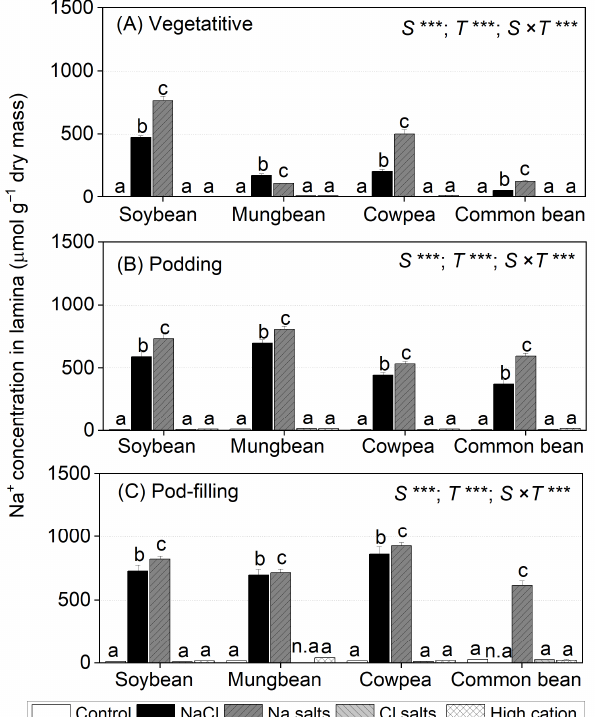
Figure 2. Na + concentration in lamina of soybean, mungbean, cowpea, and common bean grown in control (non-saline), 100 mM NaCl, 100 mM Na + (without Cl − ), 100 mM Cl − (without Na + ), and high-cation negative control (K + , Mg 2+ , and Ca 2+ equivalent to those in the 100 mM Cl − treatment) treatments. The salts used in the various treatments are given in Table 1. The treatments were imposed on 13-day-old plants and sampled after ( A ) 15 (vegetative stage), ( B ) 36 (podding stage), and (C57 (pod-filling stage) days of treatment. The values are means ± SE ( n = 4). Significant differ- ences for treatment means within each species are indicated by different letters (a–c) ( p = 0.05). The probability levels for two-way ANOVA were used to compare species (S), treatment (T), and spe- cies × treatment interaction (S × T) effects (*** p < 0.001). Note: Mungbean subjected to Cl – (without Na + ) and common bean subjected to the NaCl treatment did not have enough green leaf lamina at the pod-filling stage for ion analysis, as indicated by n.a. Na + concentrations in shoots, roots, peti- oles, and stems are presented in Table S2, Figure S2–S3; Na + concentrations in flowers, pod walls, and seeds are presented in Figure S10.